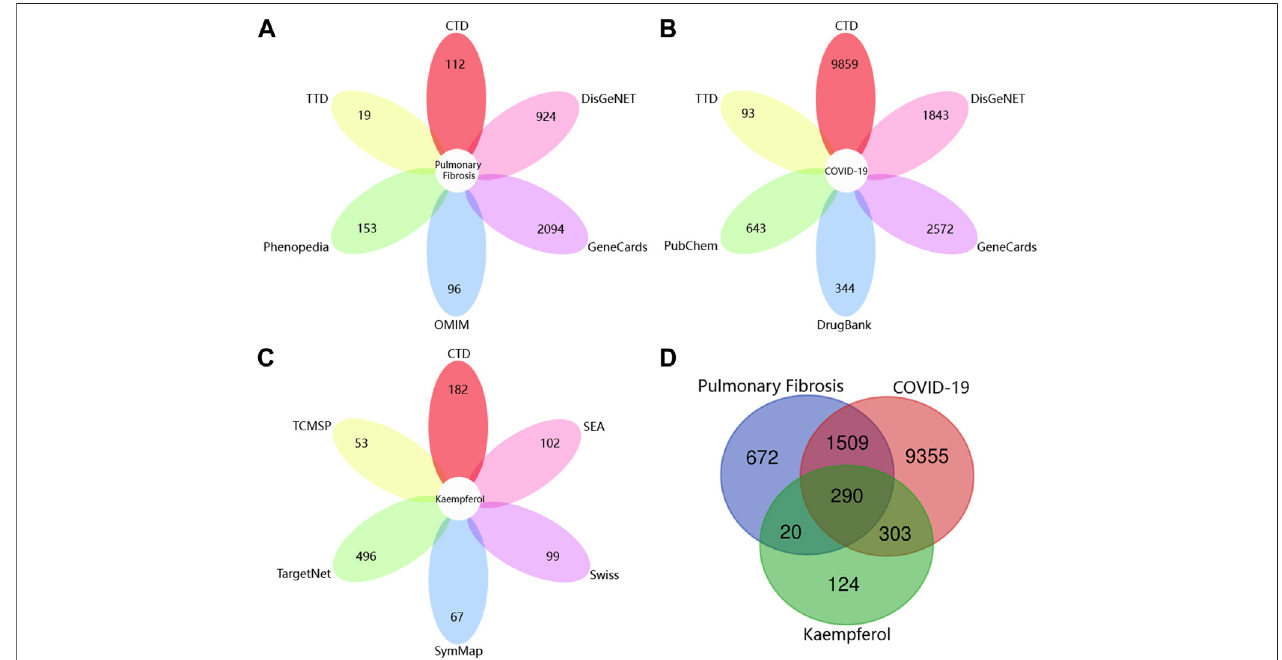
FIGURE 2 | Collection of targets related to drug and diseases from various open-source databases. (A) The number of pulmonary fi brosis-related targets from six open-sourcedatabases. (B) ThenumberoftargetsrelatedtoCOVID-19fromsixopen-sourcedatabases. (C) Thenumberoftargetsassociatedwithkaempferolfromsix open-source databases. (D) Venn diagram depicting common targets between COVID-19, pulmonary fi brosis and kaempferol.